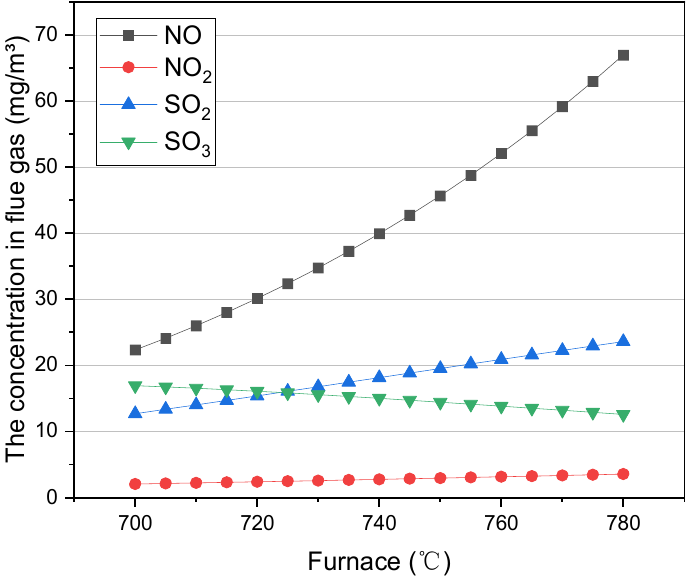
Figure 7. Sensitivity analysis as the function of furnace temperature.